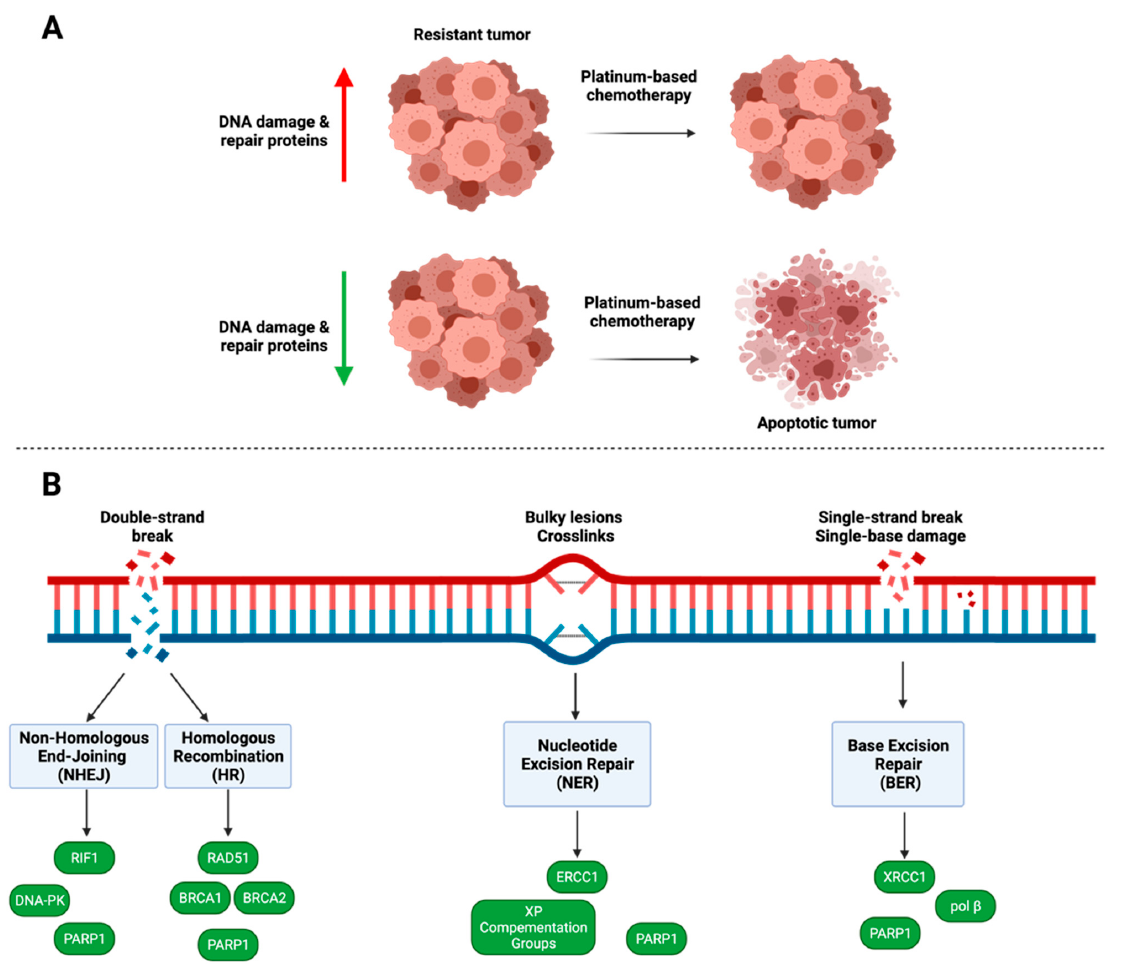
Figure 3. ( A ) Increased expression of DNA damage and repair proteins can cause resistance to